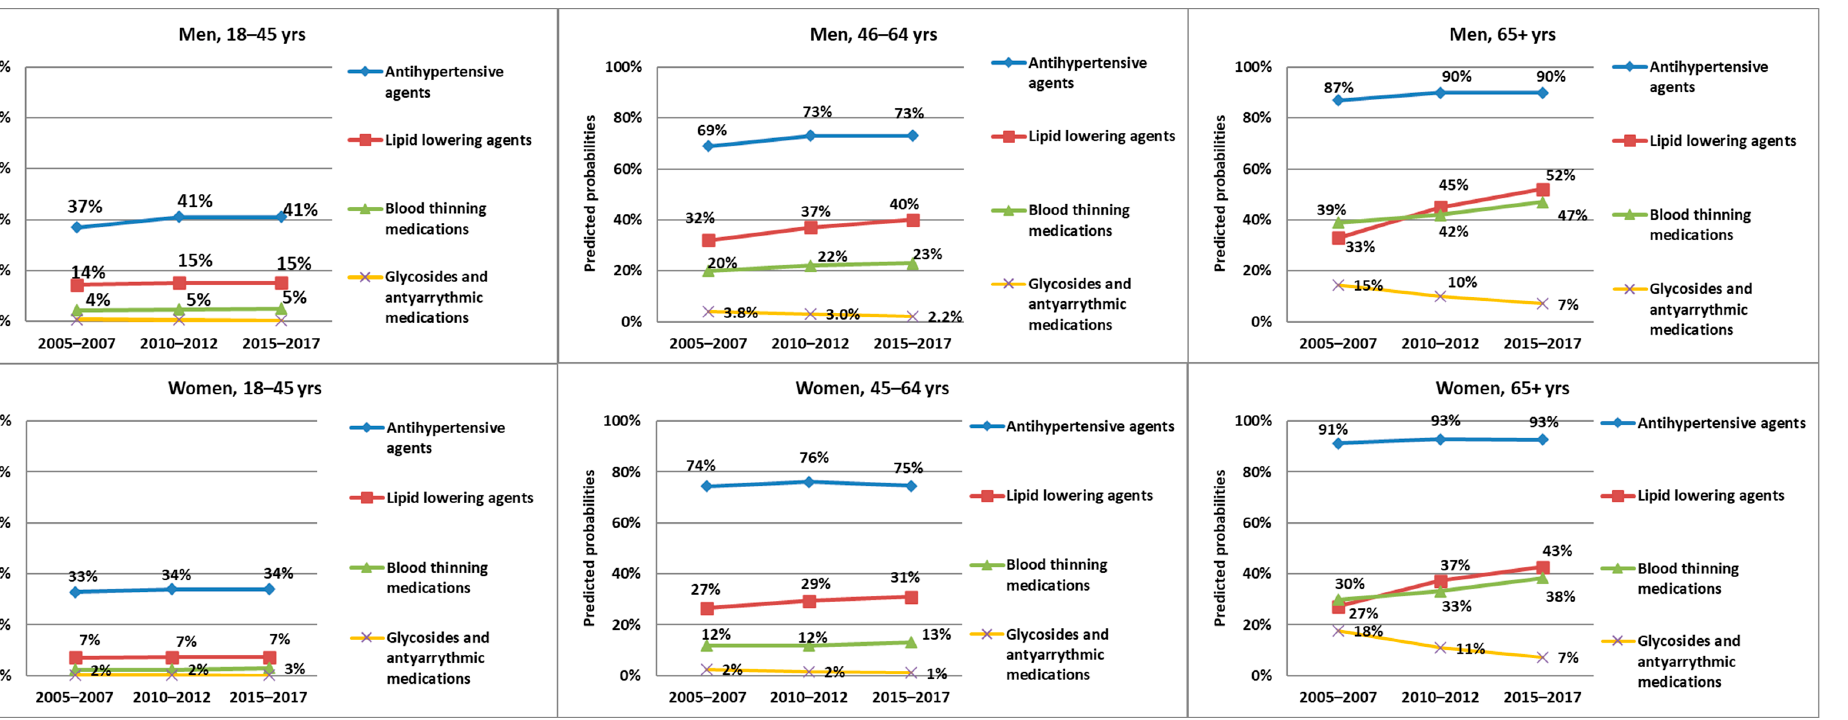
Figure 3. Predicted probabilities of the prescription of CVD medications over the three time periods, stratified by gender and three age groups.